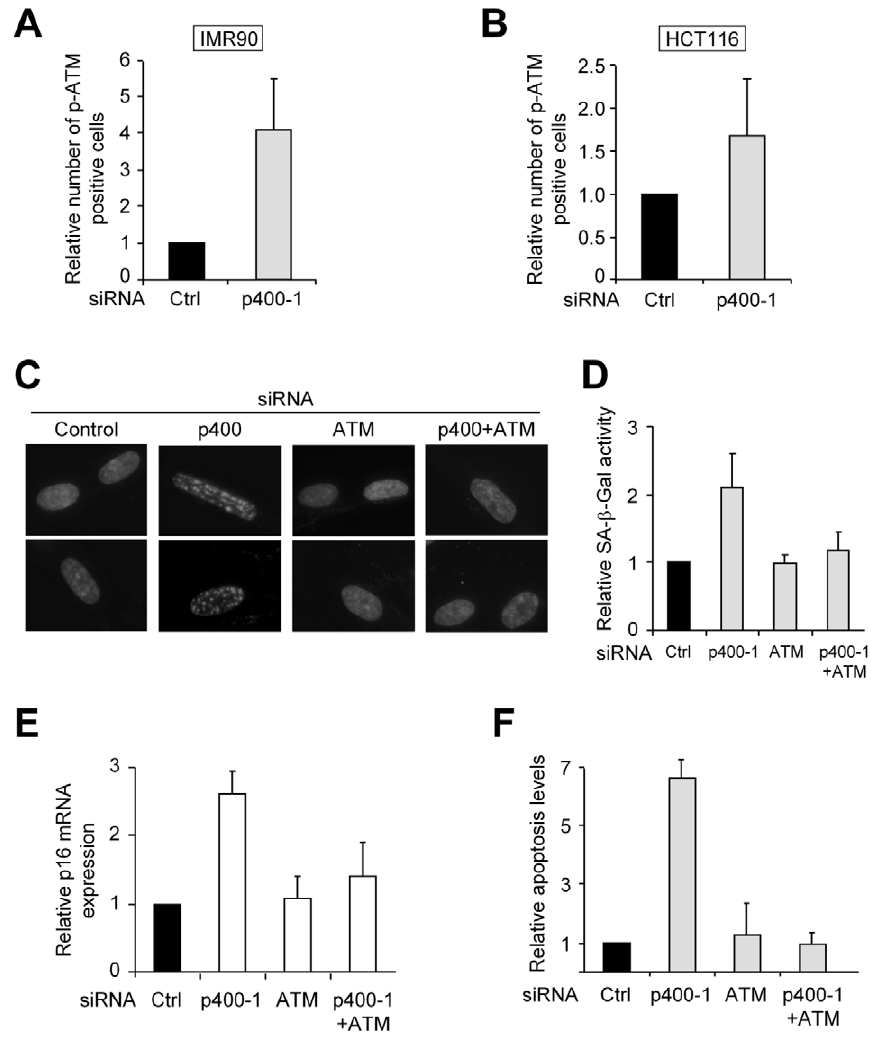
Figure 5. The ATM–dependent DDR is required for senescence and apoptosis induced by p400. (A,B) IMR 90 cells (A) or HCT 116 cells (B) were transfected using the indicated siRNA. 48 h following transfection, cells were fixed and analysed by immunofluorescence using an anti- phosphoATM antibody. PhosphoATM positive cells were quantified using ImageJ software and calculated relative to 1 for cells transfected with the control siRNA. The mean and SD from three independent experiments are shown. (C) IMR 90 cells were transfected with the indicated siRNA alone or in combination. The total amount of siRNA in the transfection was kept constant using the control siRNA. 7 days following transfection, cells were collected and subjected to DAPI staining to analyse SAHF formation. (D) Same as in (C), except that Senescence associated b -galactosidase activity was measured and calculated relative to 1 for cells transfected with the control siRNA alone. The mean and SD from three independent experiments are shown. (E) Same as in (C) except that mRNA were extracted and reverse transcribed. cDNAs were then analysed by Q-PCR for p16 and GAPDH mRNA expression. The amount of p16 cDNA was divided by the amount of GAPDH cDNA and calculated relative to 1 for cells transfected using the control siRNA alone. The mean and SD from three independent experiments are shown. (F) HCT116 cells were transfected with the indicated siRNA alone or in combination. The total amount of siRNA in the transfection was kept constant using the control siRNA. 48 h following transfection, apoptosis induction was measured by flow cytometry and the percentage of apoptotic cells was calculated relative to 1 for cells transfected with the control siRNA. The mean and SD from three independent experiments are shown. (Figure 5D) and induction of p16 mRNA expression (Figure 5E).